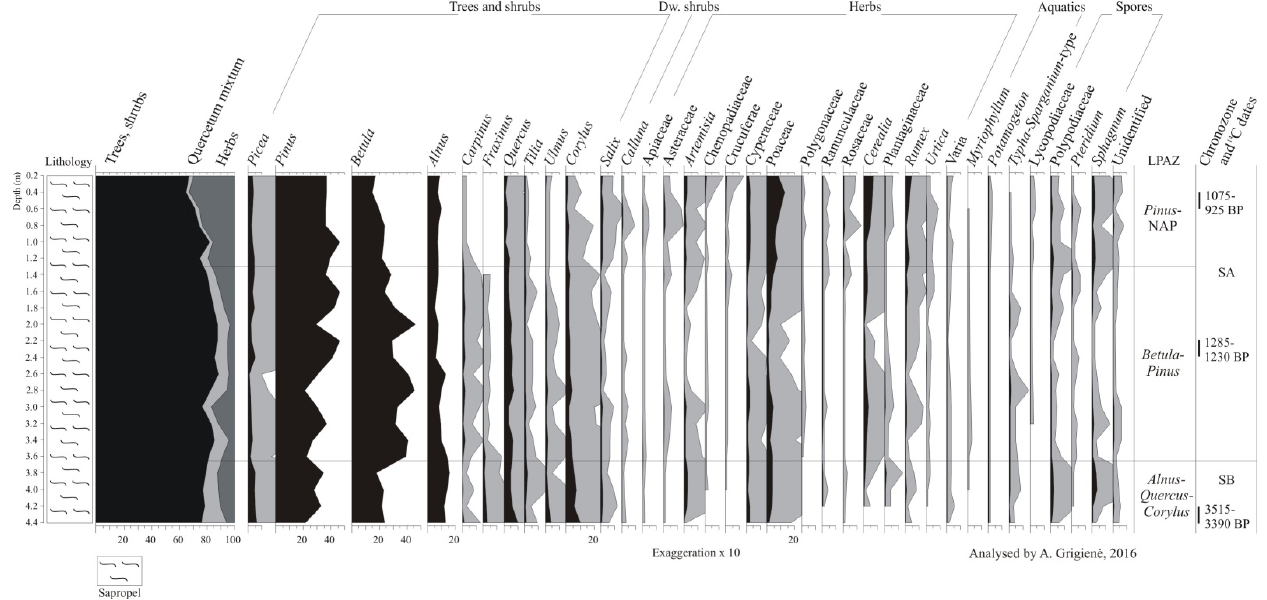
Figure 9. Percentage pollen diagram of the core from Lake Gineitišk ė s.